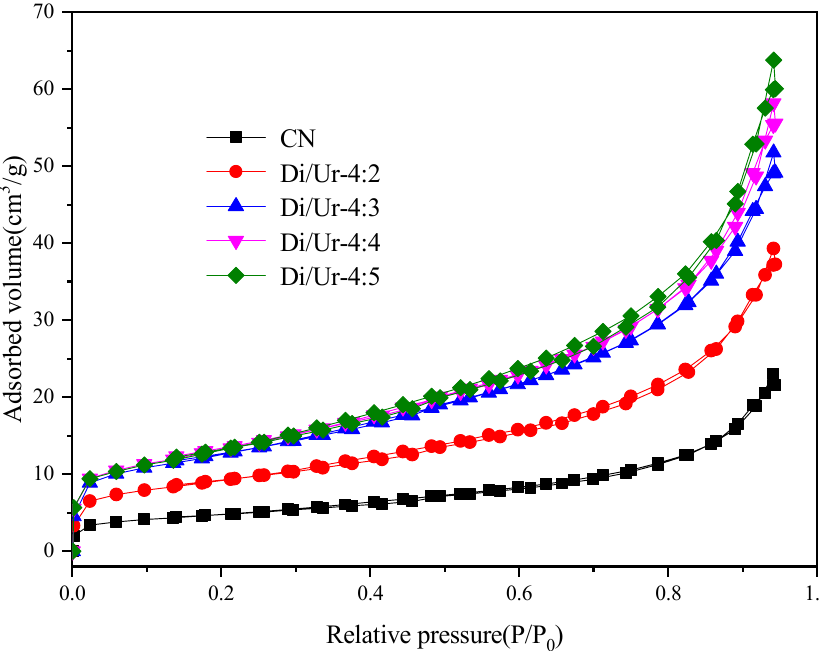
Figure 3. Nitrogen adsorption–desorption isotherms of g-C 3 N 4 and the as-prepared Di/Ur compo- site.